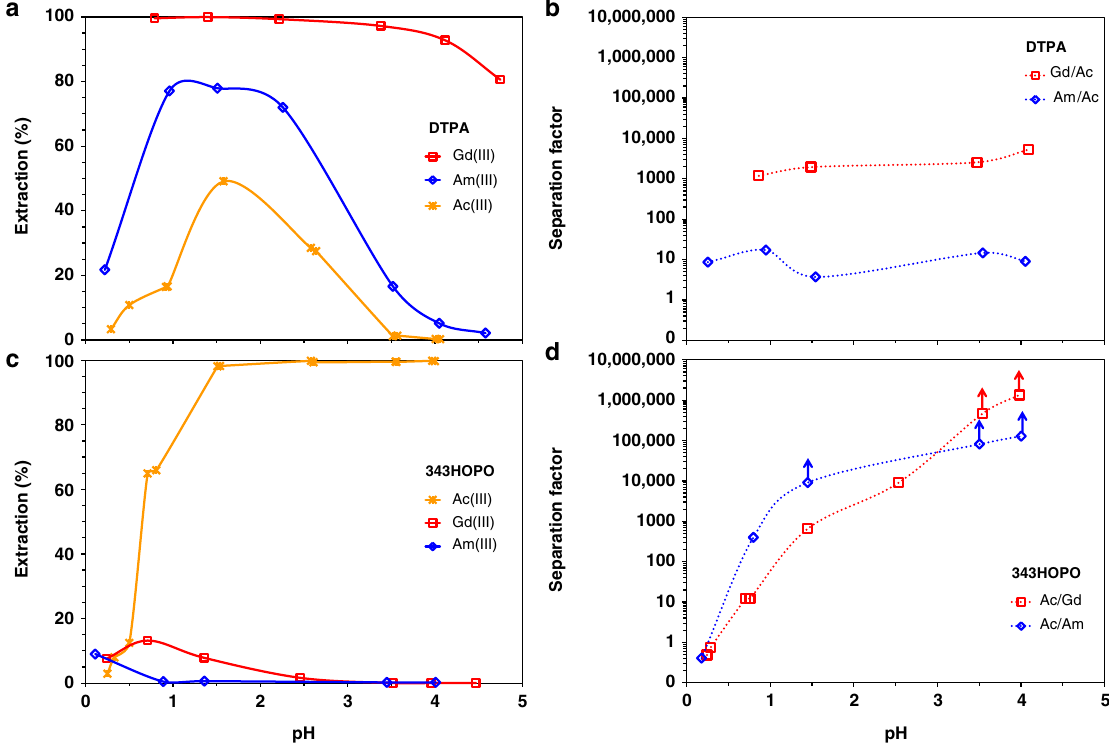
Fig. 3 Separation of Ac from Gd and Am. Extraction yield of trivalent Ac (stars), Gd (squares), and Am (circles) by 0.5 M HDEHP as a function of pH, in the presence of DTPA ( a ) or 343HOPO ( c ). A logarithmic scale is used due to the low extraction yields of Pu 4 + . The corresponding separation factors in the presence of DTPA or 343HOPO are given in b and d , respectively. Aqueous phase: 40 mM of chelator in sodium lactate/sodium nitrate buffer ( I = 2 M). V V = 1, one contact. T = 25 °C. Data points with arrows are lower org / aq